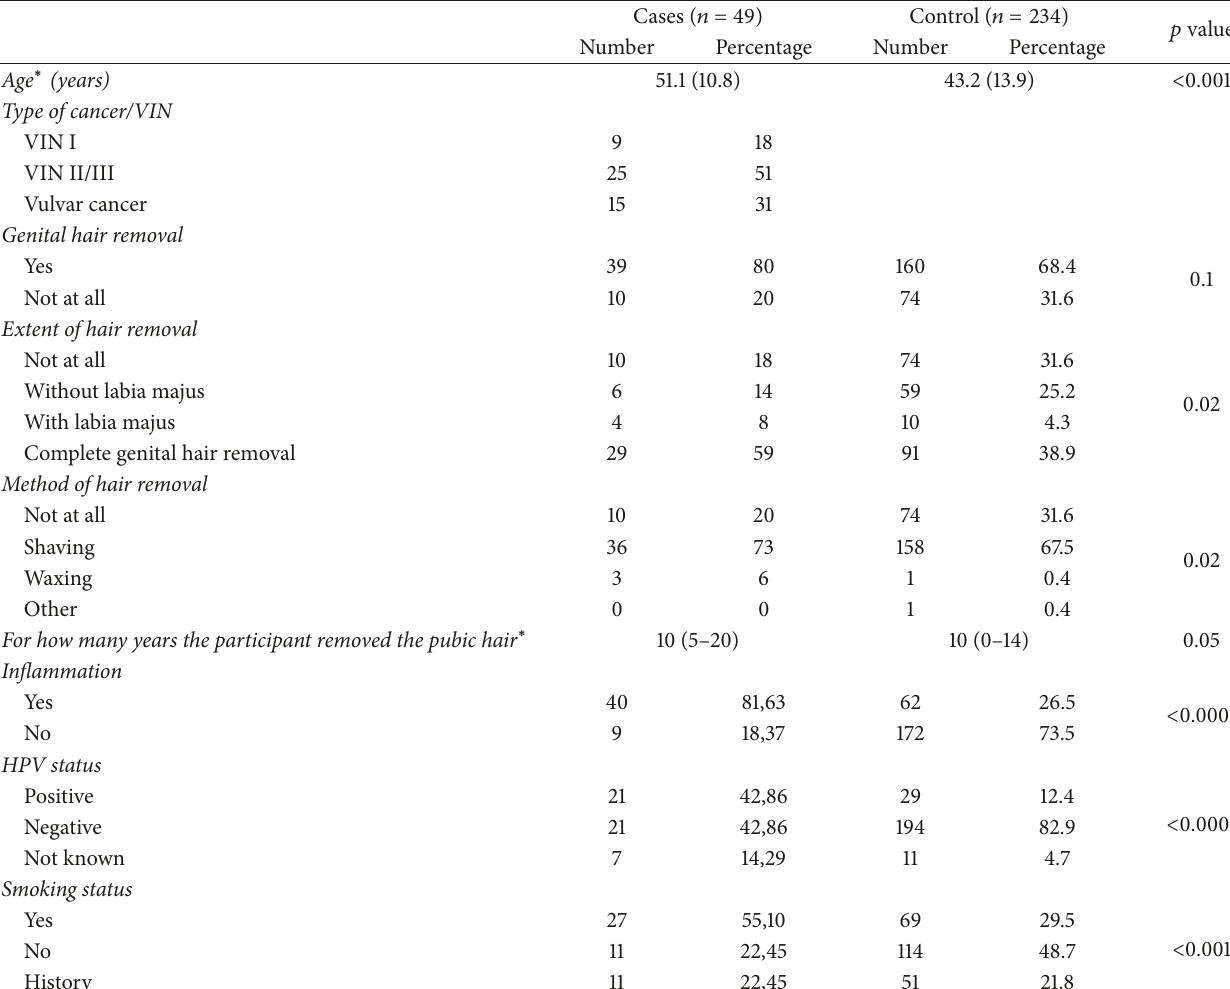
Table 1: Descriptive representation of cases and controls.